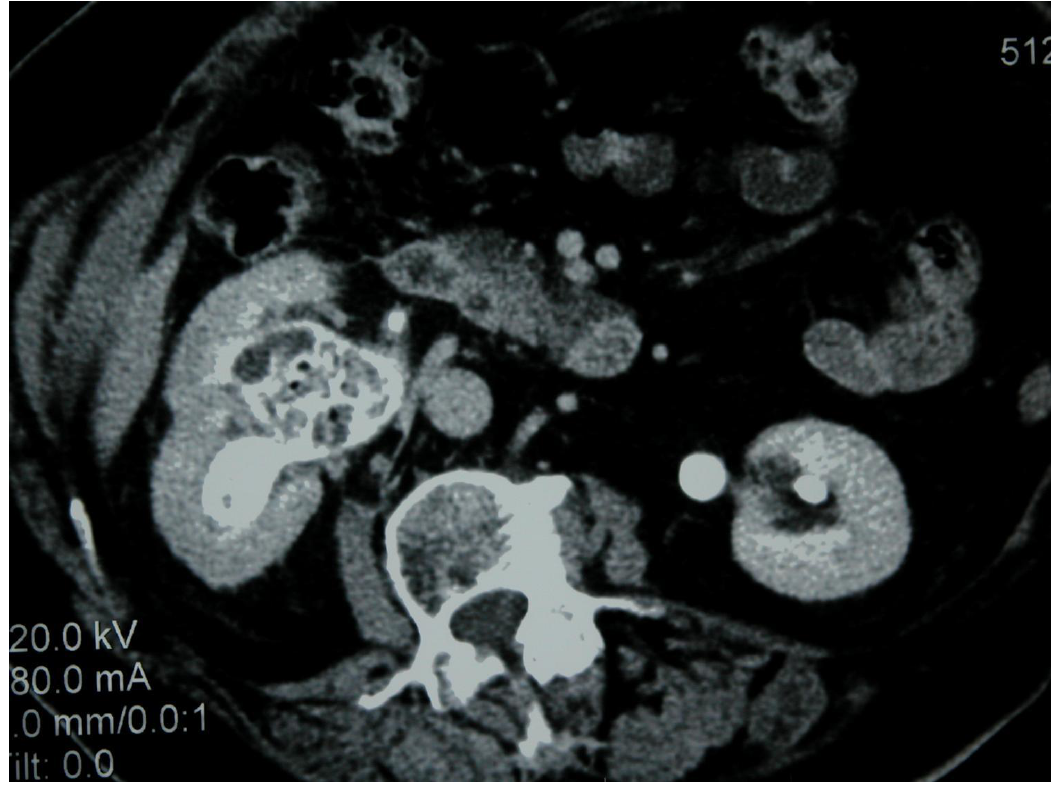
FIGURE 1. CT urography showing the extensive filling defect of the right renal pelvis and air